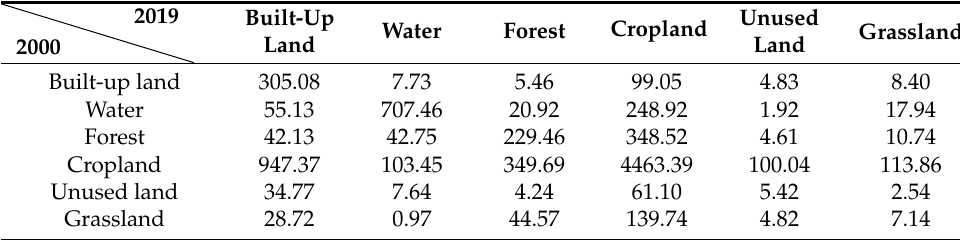
Table 4. Land use conversion matrix of Wuhan in period